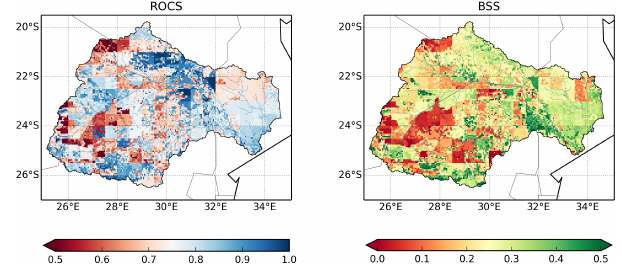
Figure 8. ROCS and BSS for DJFMAM RS >70th percentile for the FS_S4.